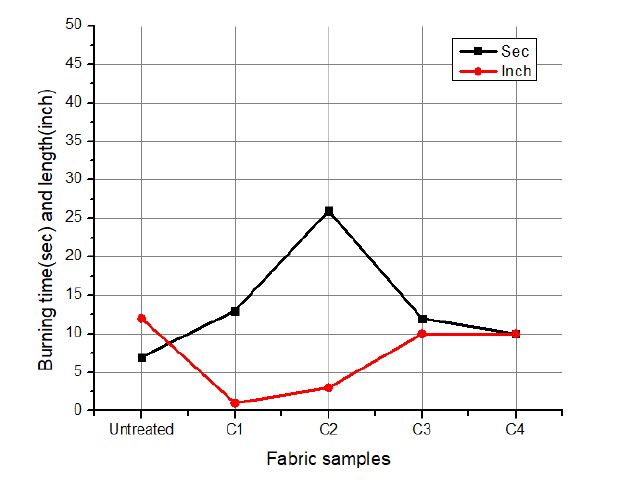
Fig. 1. Graphical representation of burning length and time of